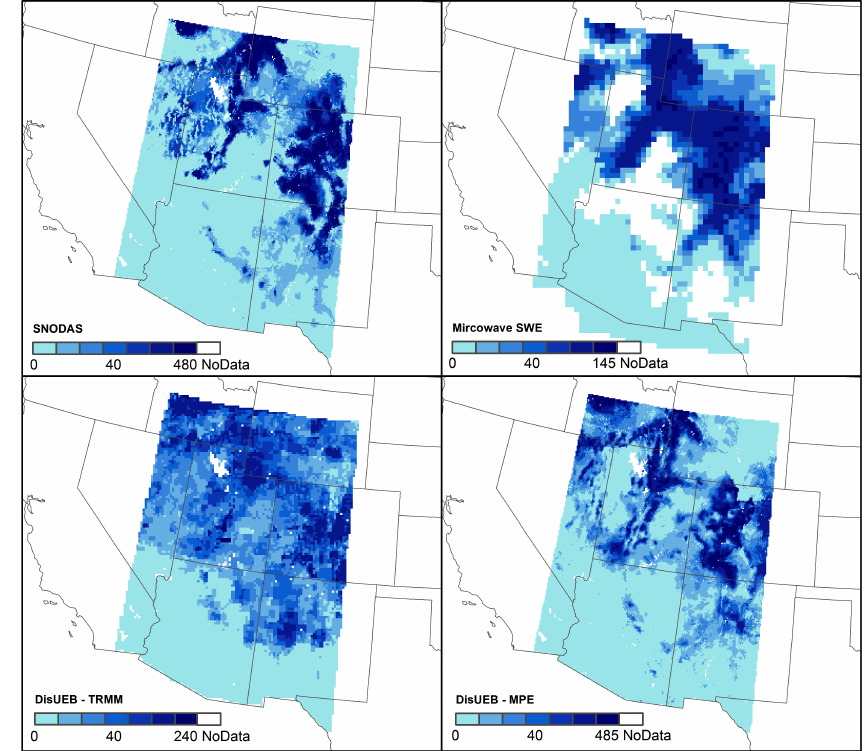
Fig. 5. Average SWE for February 2007 predicted with the distributed UEB model, microwave imagery, and SNODAS. Over 40% of the area had missing data for the SWE data set estimates from the microwave imagery.